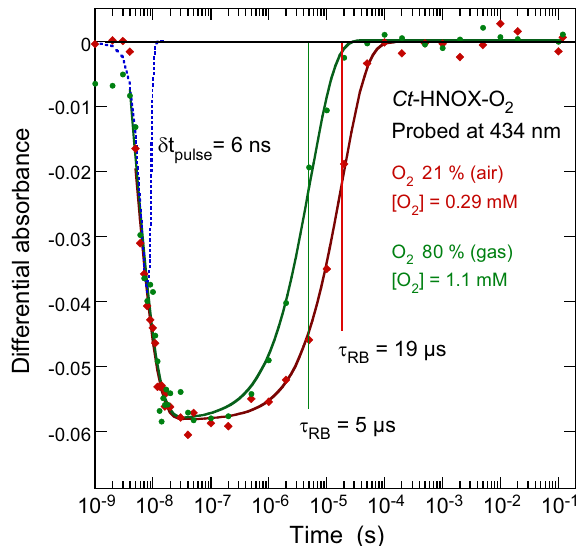
Fig. 4 Dynamics of O 2 rebinding to Ct H-NOX in the ns to 0.1 s time scale. The dynamics was probed at 434 nm in the presence of 21% O 2 and ~80% O 2 in the gas phase. In the fi rst case, the sample cell was open to the air. In the second case pure O 2 (Air Product) was injected into the open cell. The kinetics were fi tted to the sum of two exponential components. The fi rst fast component ( τ 1 = ~4 ns) corresponds to the rise of the signal (leading edge of the pulse). The second exponential is assigned to O 2 bimolecular rebinding from solution because its time constant depends on O 2 concentration ( τ 2 = 19 and 5 µ s). The pro fi le of the 6-ns gaussian pulse is indicated by the blue dotted